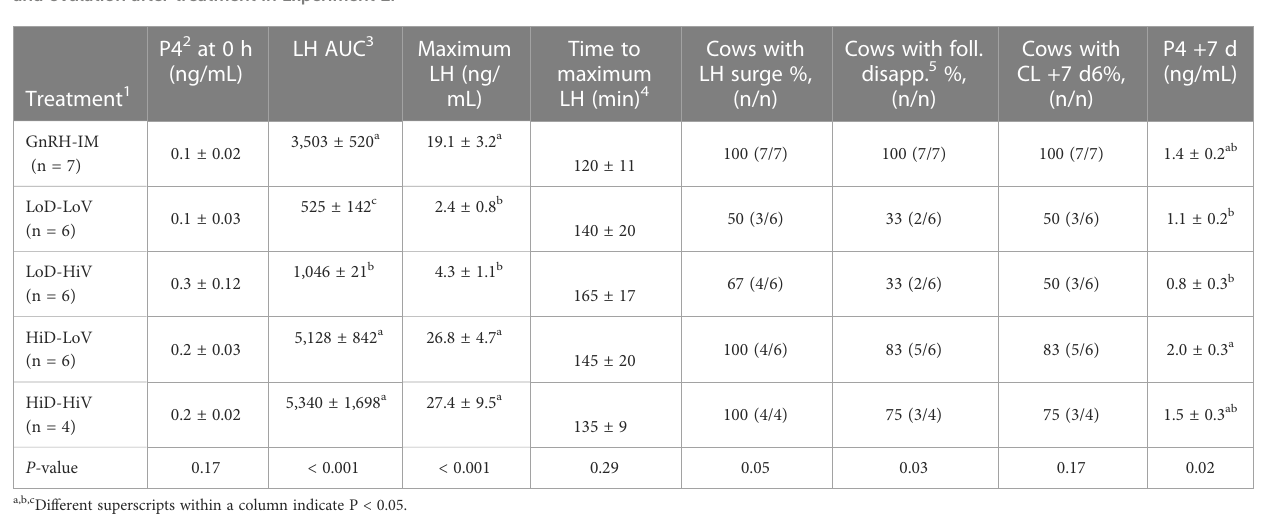
TABLE 2 Circulating concentrations of progesterone (P4) at 0 h relative to treatment administration, luteinizing hormone (LH) secretion dynamics, and ovulation after treatment in Experiment